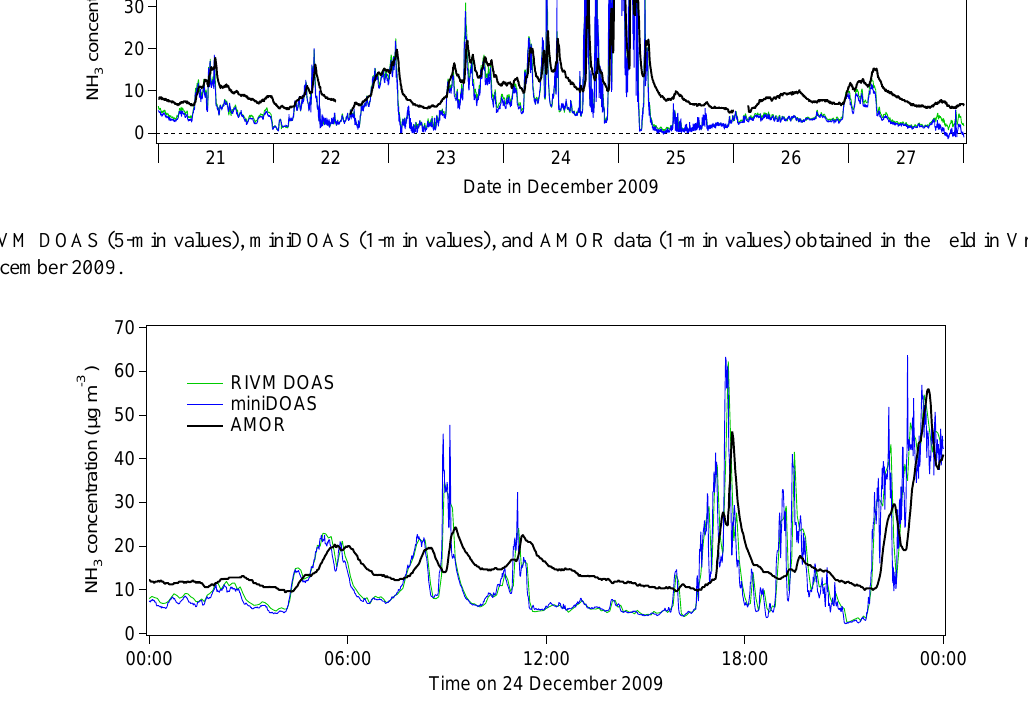
Fig. 18. RIVM DOAS (5-min values), miniDOAS (1-min values), and AMOR data (1-min values) obtained in the field in Vredepeel on 24 December 2009.